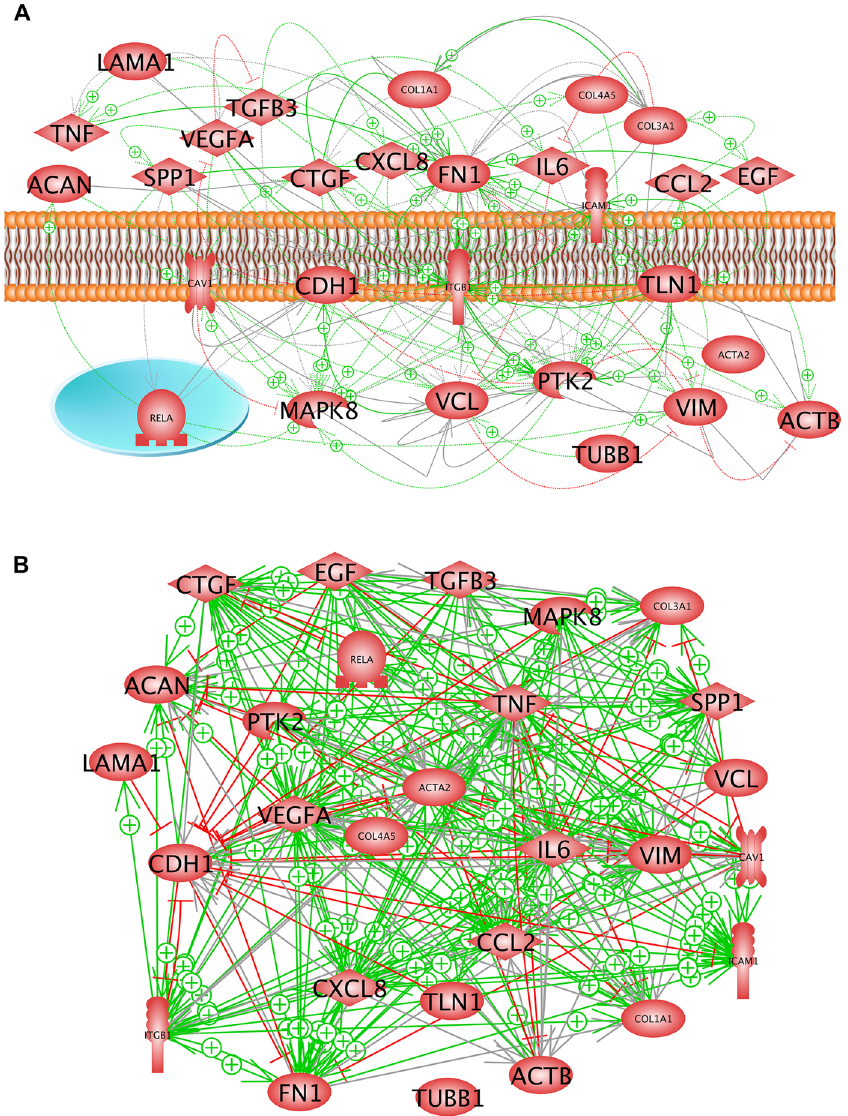
partner; red line: inhibition of indicated partner. Grey solid lines indicate possible complex formation, solid arrows point to direct interaction and dashed arrows to indirect influence. Membrane and nucleus (blue circle) mark predominant localization of the proteins. ( B ) Pathway studio analysis on the expression of investigated genes. The color of shown lines indicates the type of interaction: green line: promotion of indicated partner; red line: inhibition of indicated partner. Arrows indicate the direction of